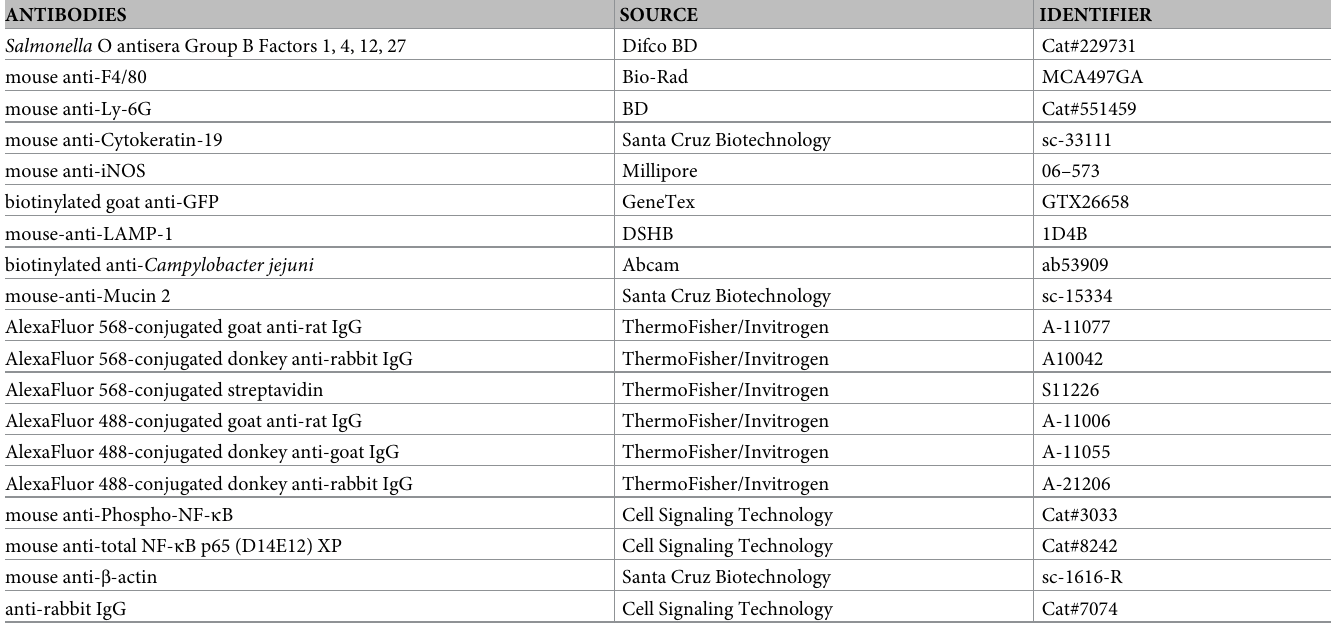
Table 2. Antibodies used in this